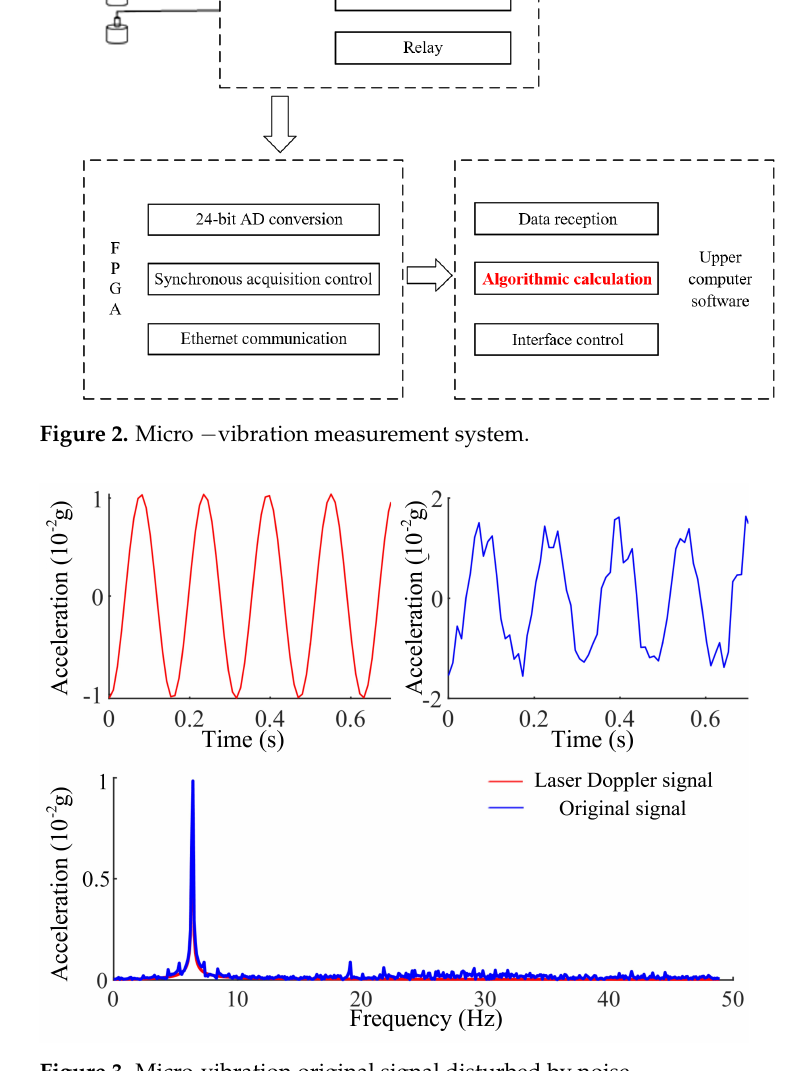
Figure 3. Micro-vibration original signal disturbed by